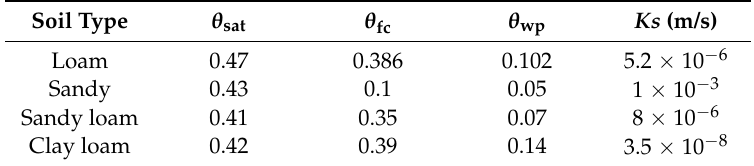
Table 2. Soil hydraulic parameterization of the two-layer model for the unsaturated